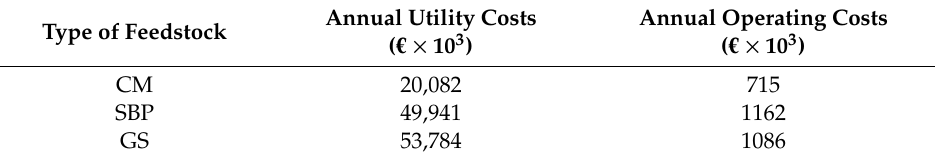
Table 12. Annual utility and operating costs of the biogas power plant.